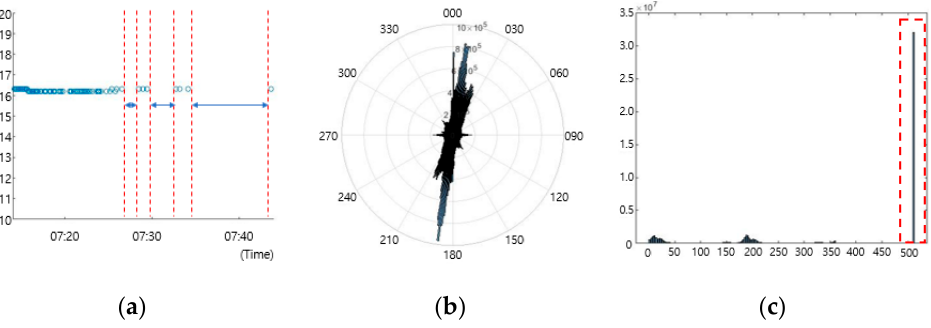
Figure 3. Observations of the data examination: ( a ) inconsistent time-series, ( b ) COG distribution, ( c ) heading distribution.